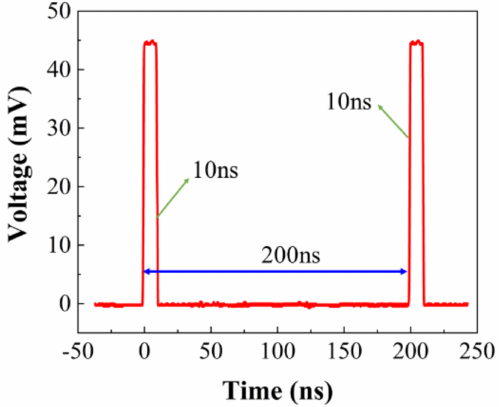
Figure 1. Time-domain waveform of Pulse pair